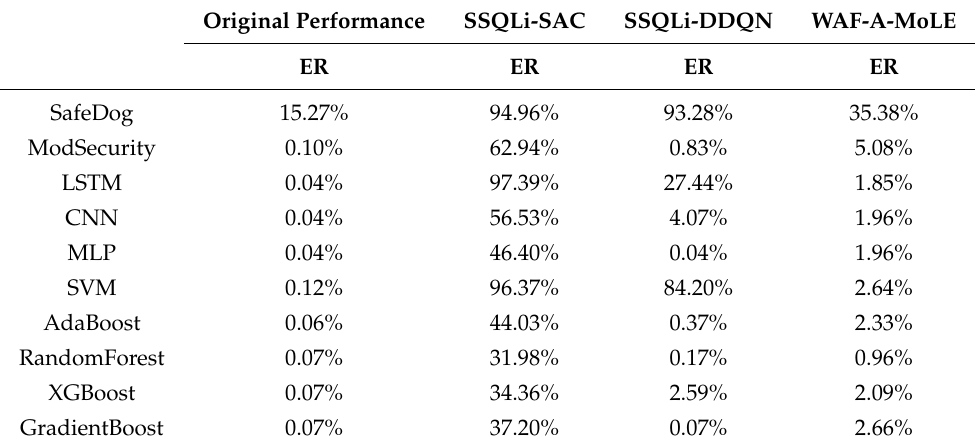
Table 9. Comparison of detection performance of three adversarial attack methods on the detector.